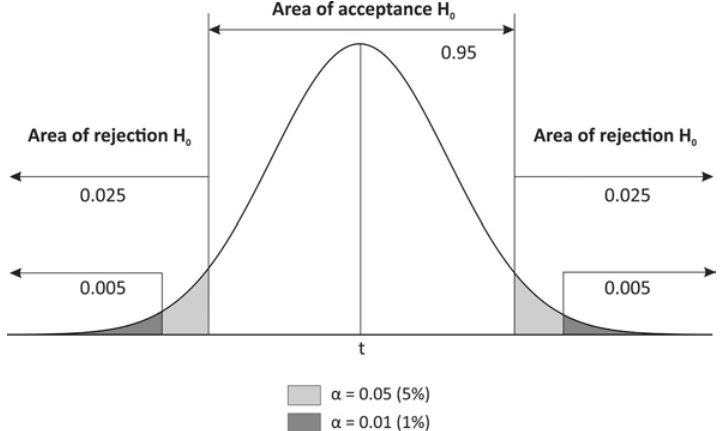
Fig. 2. Areas of the acceptance and rejection of a hypothesis in ANOVA. Source: authors’